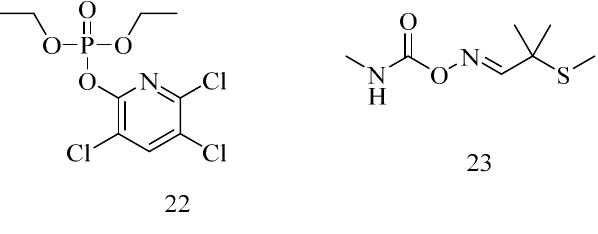
Figure 8. Chlorpyrifos and aldicarb.